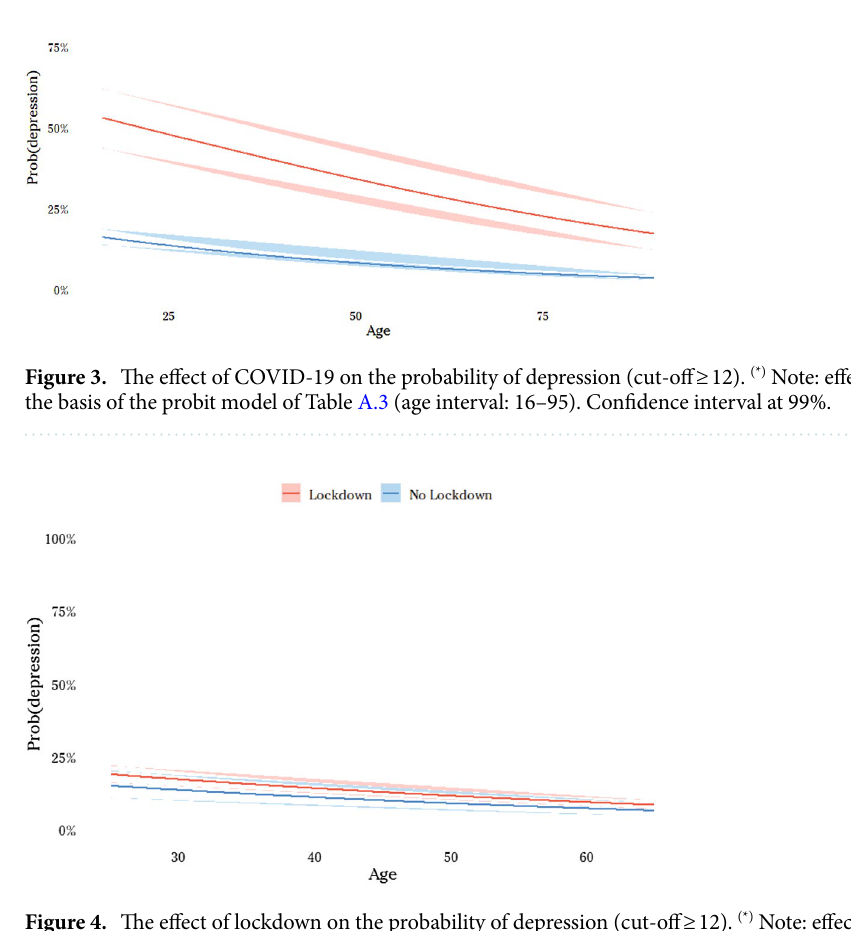
Figure 4. The effect of lockdown on the probability of depression (cut-off ≥ 12). (*) Note: effects calculated on the basis of the probit model of Table A.3 (age interval: 25–65). Confidence interval at